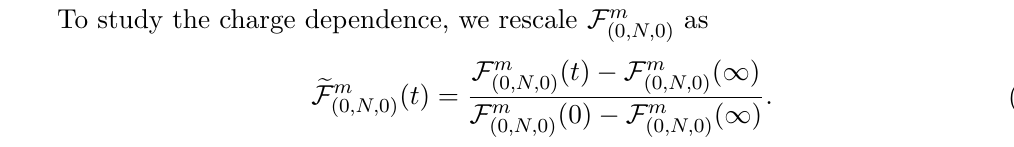
Figure 10 . The rescaled charge resolved OTOCs e F m in (b) for different m and N plotted against the transformed time variable ˜ t ρ { 50 , 60 , . . . , 440 , 450 } for N = 500 , and m = { 50 , 60 , . . . , 140 , 150 } for N = 200 . The OTOCs for different m and both the values of N collapse into a single functional form. Insets (a1) and (b1) show the corresponding unrescaled charge-resolved OTOCs F m for different m at N = 500 as a function of t